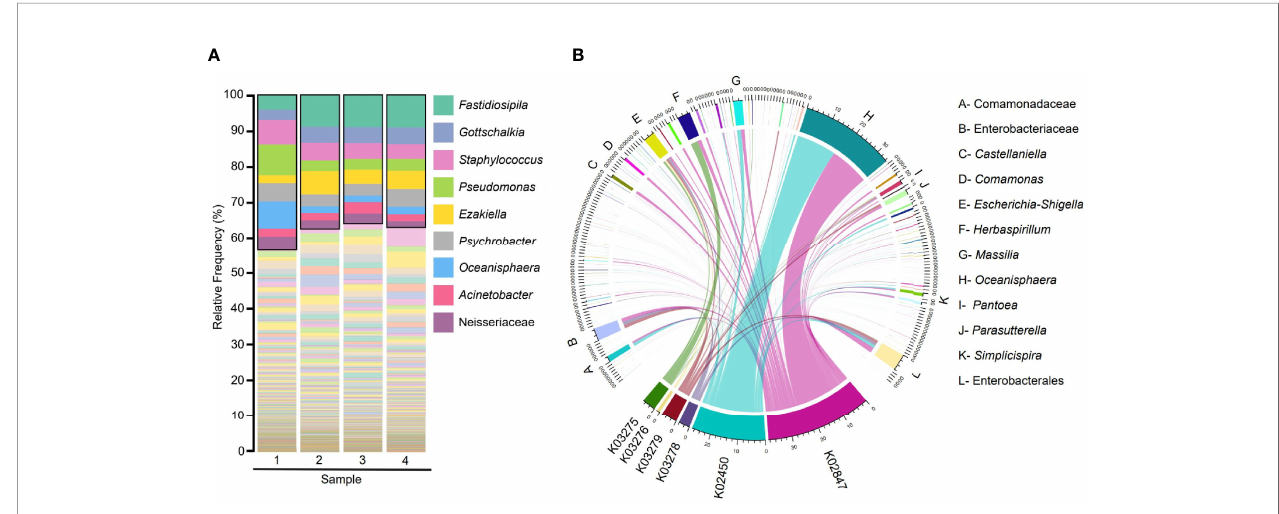
FIGURE 1 | Taxonomic and functional pro fi les of the fecal microbiome of Humboldt penguin. (A) Barplot showing the taxonomic classi fi cation of gut bacterial species from Humboldt penguin. The nine taxa with the highest relative abundance were highlighted within the black box and shown in the legend. (B) Chord diagrams representing the metagenome contribution to a 1,3GT genes in the gut microbiota of Humboldt penguin. The links indicate the linkage between the taxa and a 1,3GT genes and their width are proportional to the contribution. Node segments along the circle represent taxa or functional genes, the node ’ s width represent the abundance (measured as feature count) of contributing taxa and genes. Only taxa with contribution higher than 1% to all the functional genes were shown in the